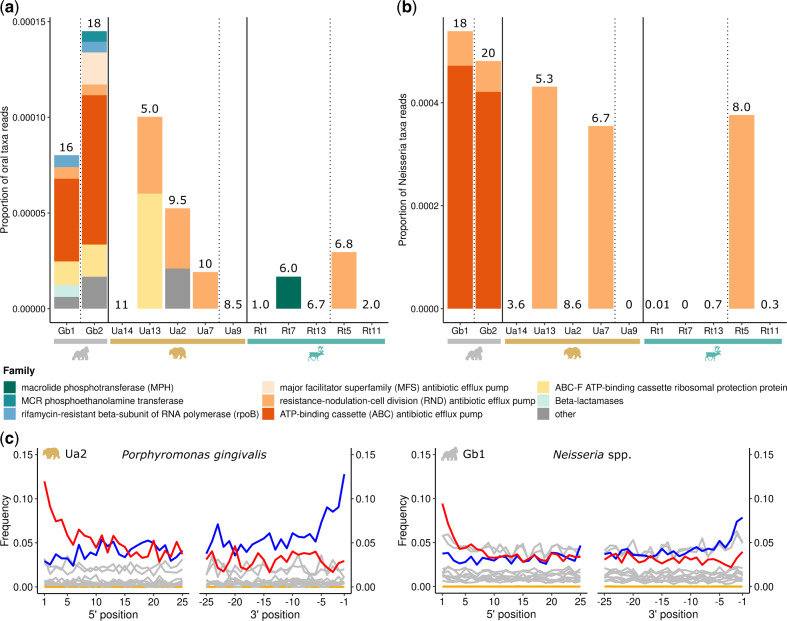
AMR genes can be recovered from historical dental calculus of wild animals. (a) Proportion of AMR genes identified in contamination-filtered reads mapping to oral bacteria (listed in supplementary table S4, Supplementary Material online) in each sample. (b) Proportion of chromosomally encoded AMR genes identified in contamination-filtered reads mapping to Neisseria species in each sample. Samples are grouped by host species and ordered by year with pre-1940 samples (preantibiotics era) separated from post-1940 samples by dashed vertical lines. The eight most abundant AMR gene families are shown, with the remainder grouped into “other.” Number of reads (in ten thousands) mapping to oral bacteria is shown above the bars for each sample in (a), and number of reads (in thousands) mapping to Neisseria taxa is shown in (b). (c) Postmortem DNA damage patterns of reads mapping to example oral bacteria: Porphyromonas gingivalis from bear Ua2 and all reads mapping to a set of Neisseria spp. reference genomes from gorilla Gb1. Frequency of C-to-T substitutions in reads compared with the reference is shown in red and G-to-A substitutions in blue. All other substitutions are shown in gray, insertions in purple, deletions in green, and soft clipping in orange, representing background noise. Misincorporation plots were generated by mapDamage.